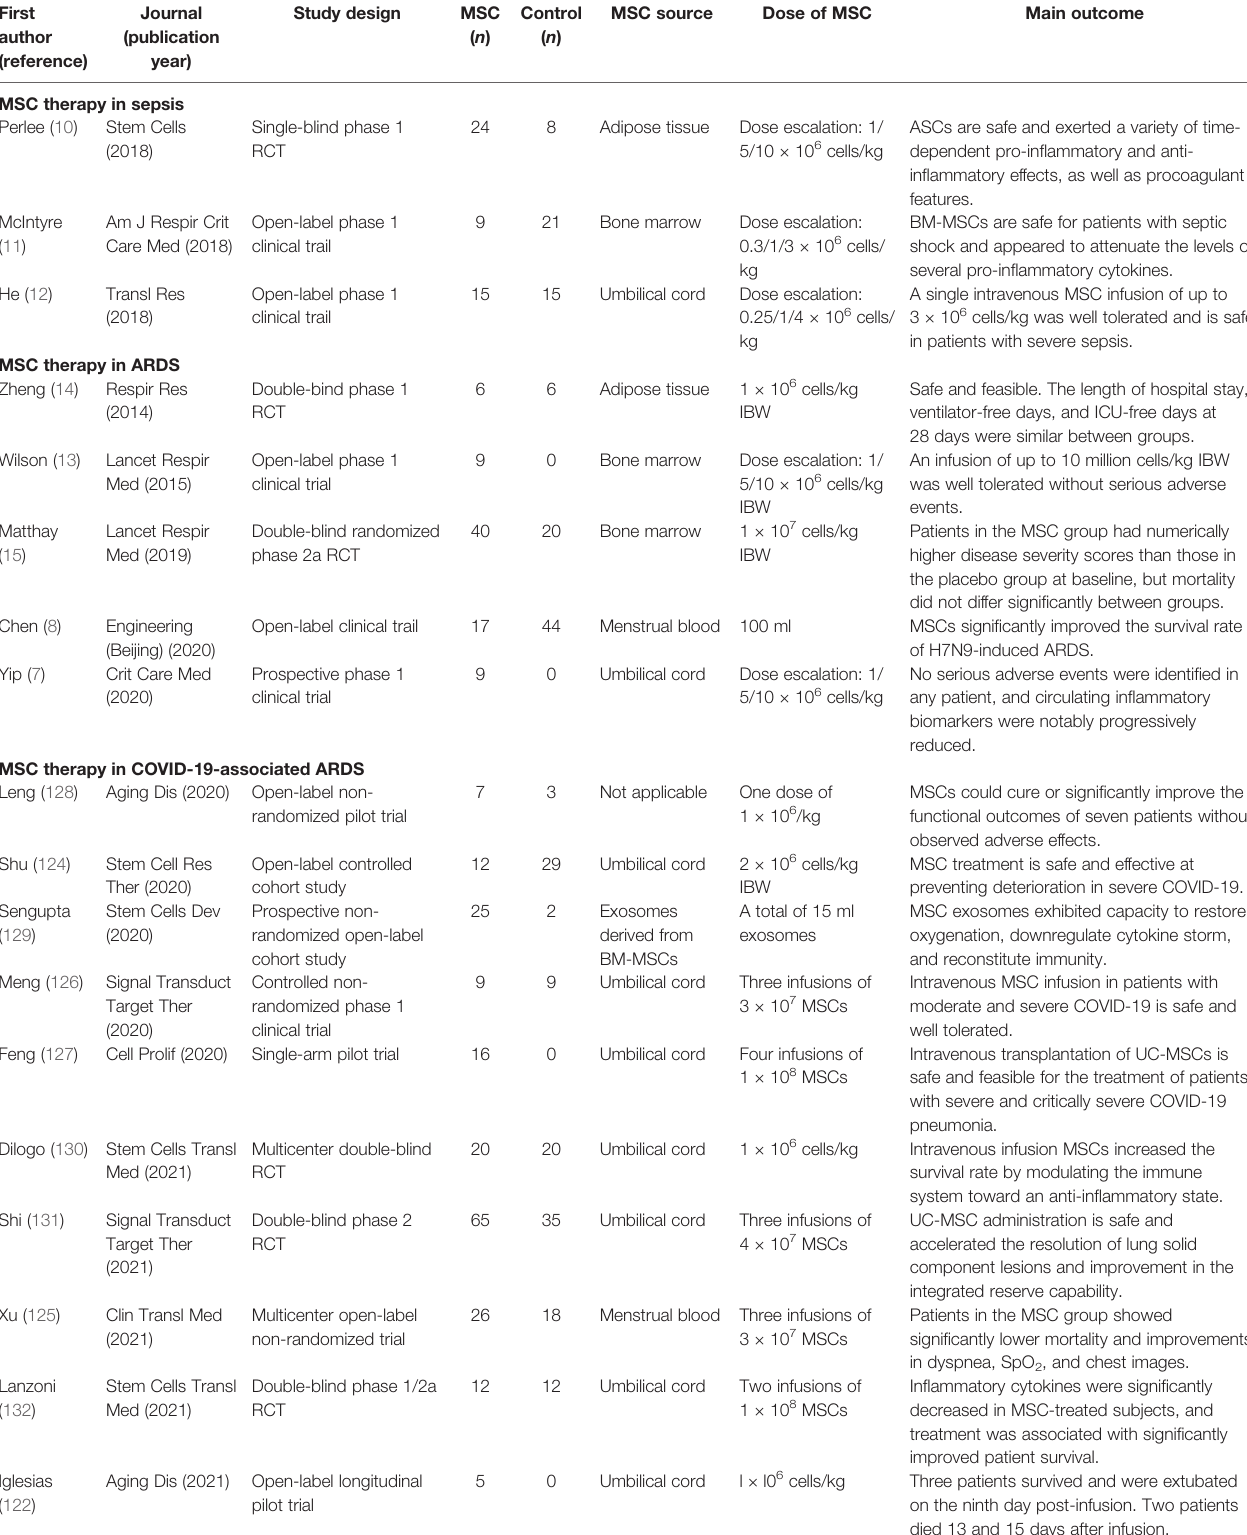
TABLE 1 | Clinical trials of mesenchymal stromal cells (MSCs) in acute respiratory distress syndrome (ARDS) and